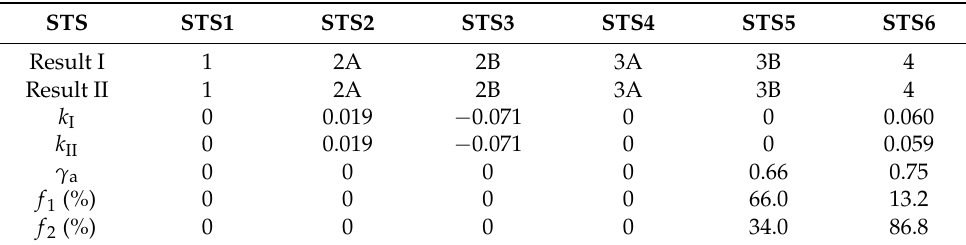
Table 1. Trend test results of the six STSs based on the MMK test and OW operation at 5% significance level.